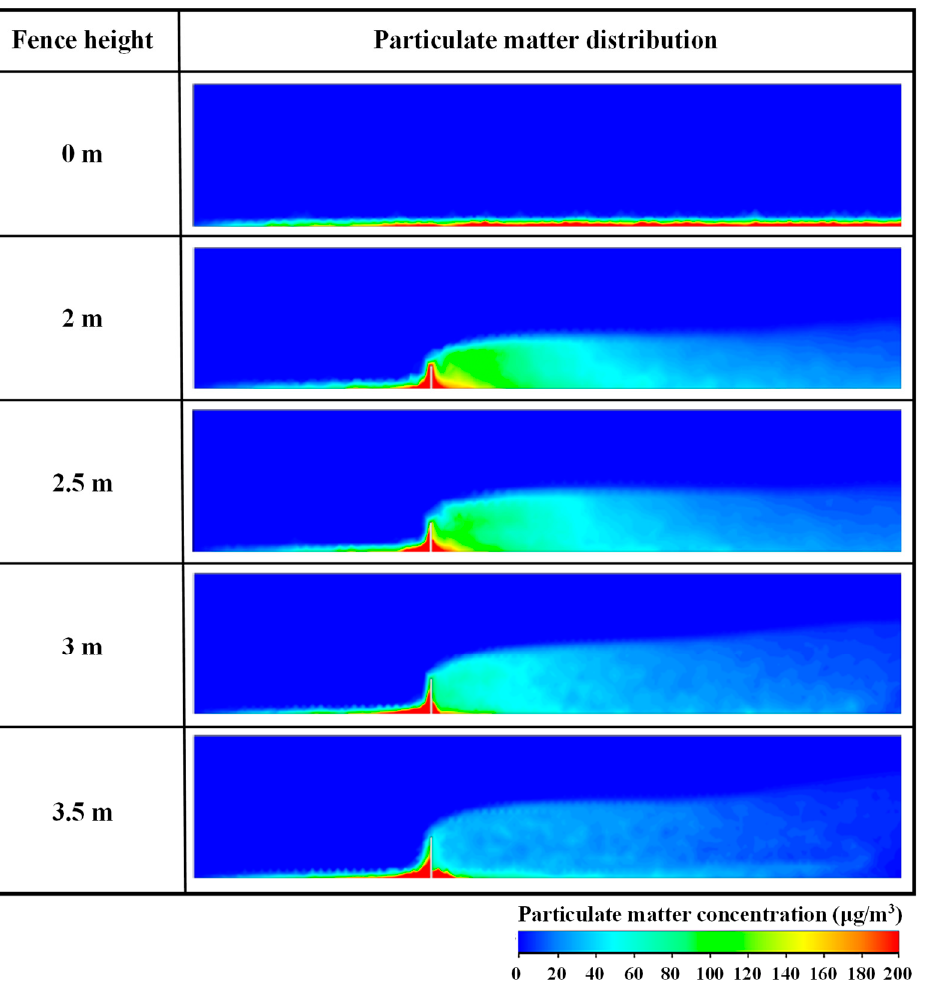
Figure 5. Mass concentration distribution of particles at different enclosure heights on monitoring section S when initial horizontal wind speed is 3 m/s.